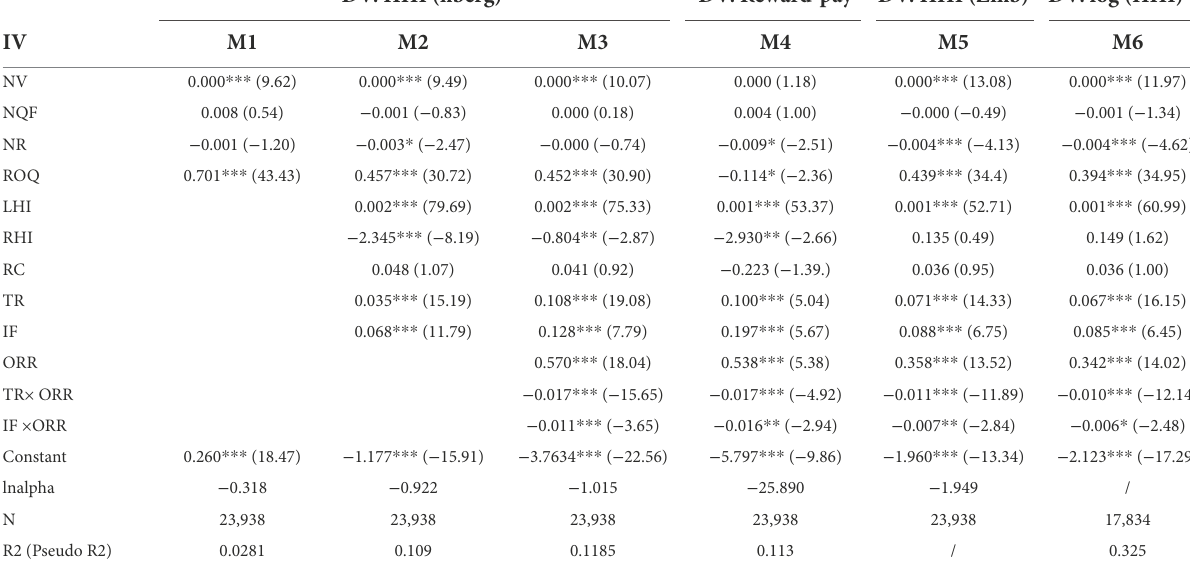
TABLE 3 Result of negative binomial model regression and robustness